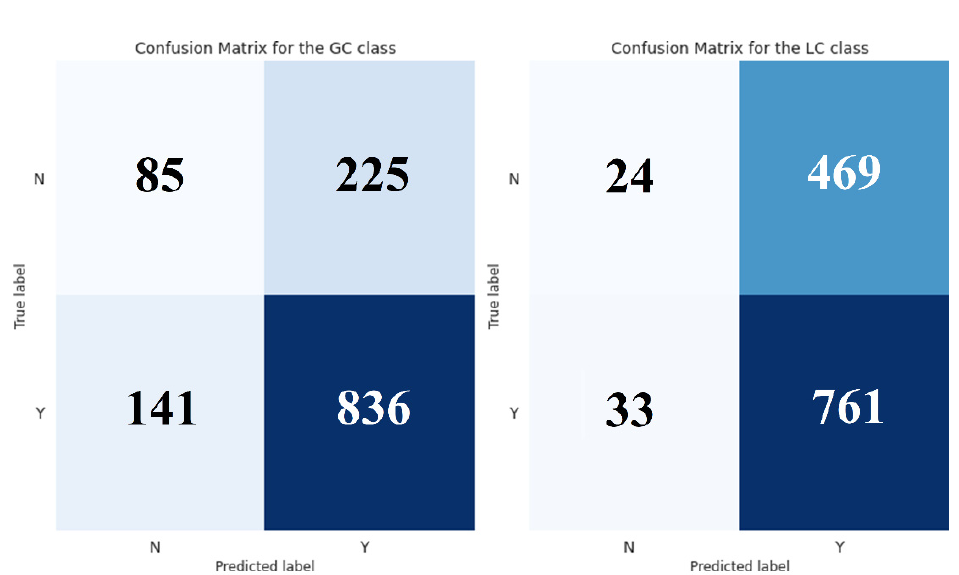
Figure 1. Confusion matrix—rule-based classifier. “Y” stands for “Yes”, indicating that a compound is amenable, while “N” stands for “No”, indicating that a compound is not amenable.